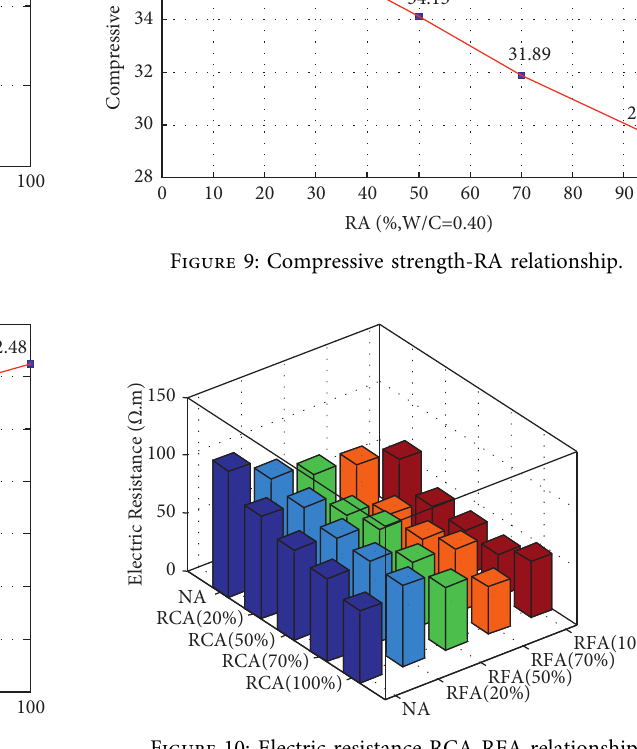
Figure 7: Water absorption-RA relationship.